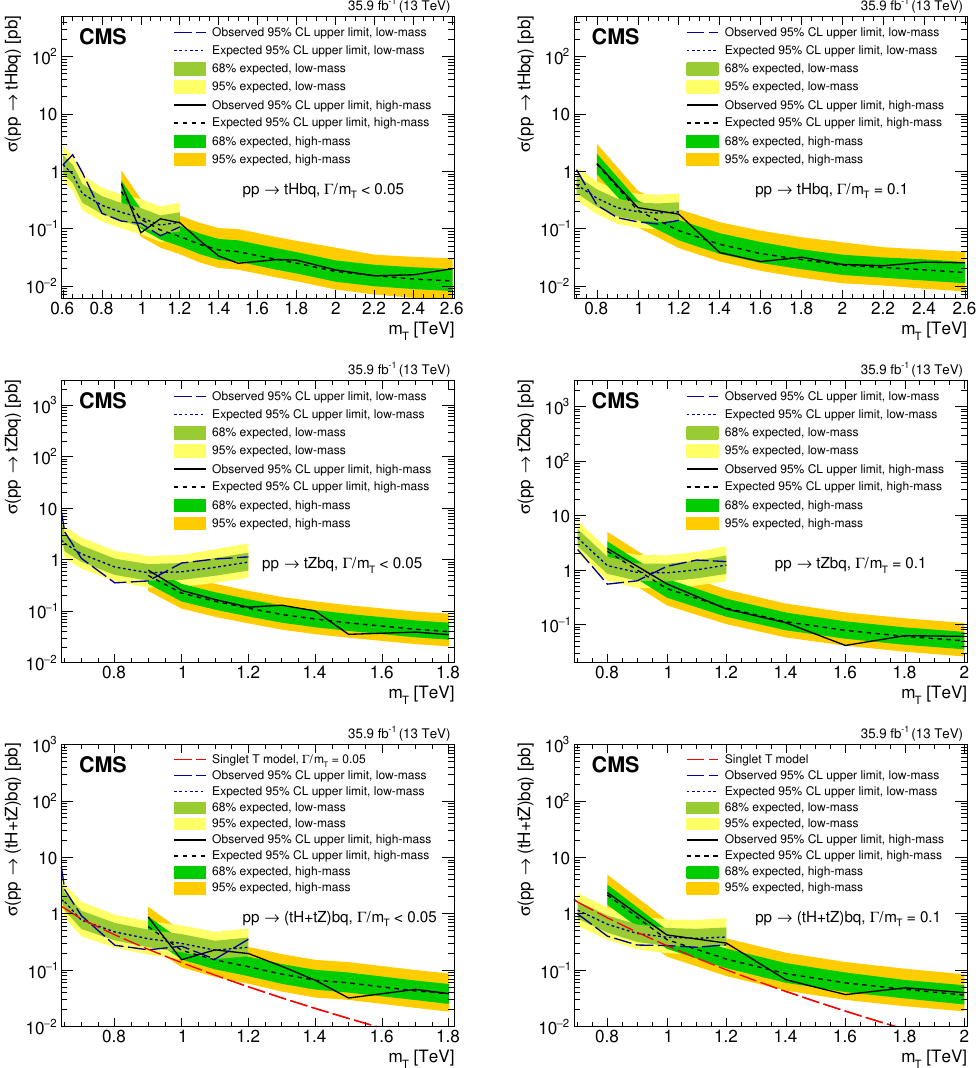
Figure 12 . The observed and median expected upper limits at 95% CL on the cross sections for production associated with a bottom quark for the tHbq (upper row) and tZbq (middle row) channels, and their sum, tHbq + tZbq (lower row), for di(cid:11)erent assumed values of the T quark mass. The inner (green) bands and the outer (yellow) bands indicate the regions containing 68 and 95%, respectively, of the distribution of limits expected under the background-only hypothesis. The (cid:20) 0 : 05) and the right column is for a fractional left column is for a narrow fractional width ((cid:0) =m T width of (cid:0) =m = 0 : 1. The dashed red curves are for the T singlet model. Given the speci(cid:12)ed T width, the couplings are implicit in the